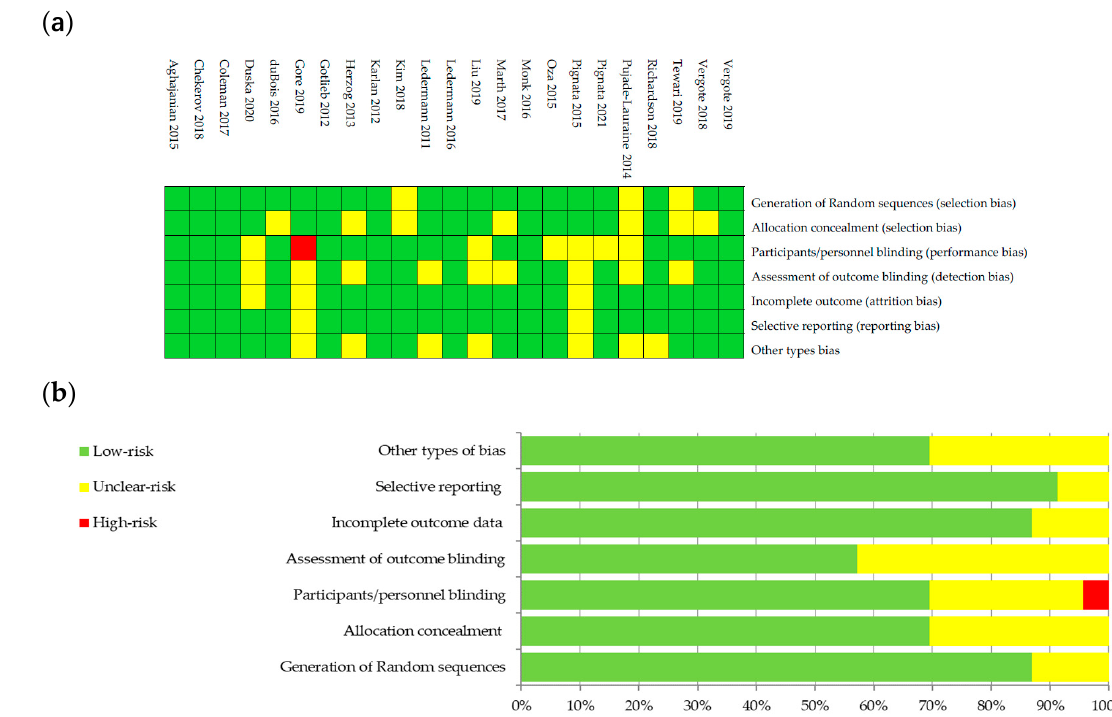
Figure 1. Graphical representation of bias risk: ( a ) authors’ judgements about each risk item color coded as low risk (green), unclear risk (yellow) or high risk (red) for studies included; and ( b ) percentage summary of bias risk across all studies, using same color coding of risk categories.